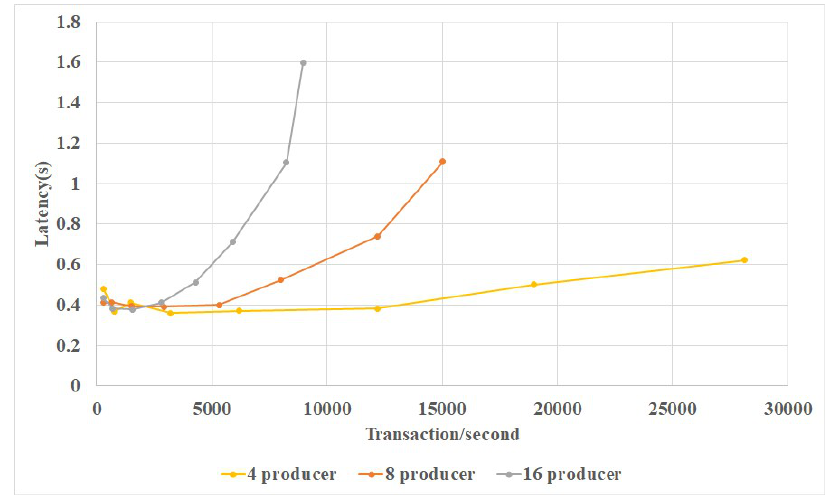
Figure 7. Relationship of transaction amount and block latency for single data